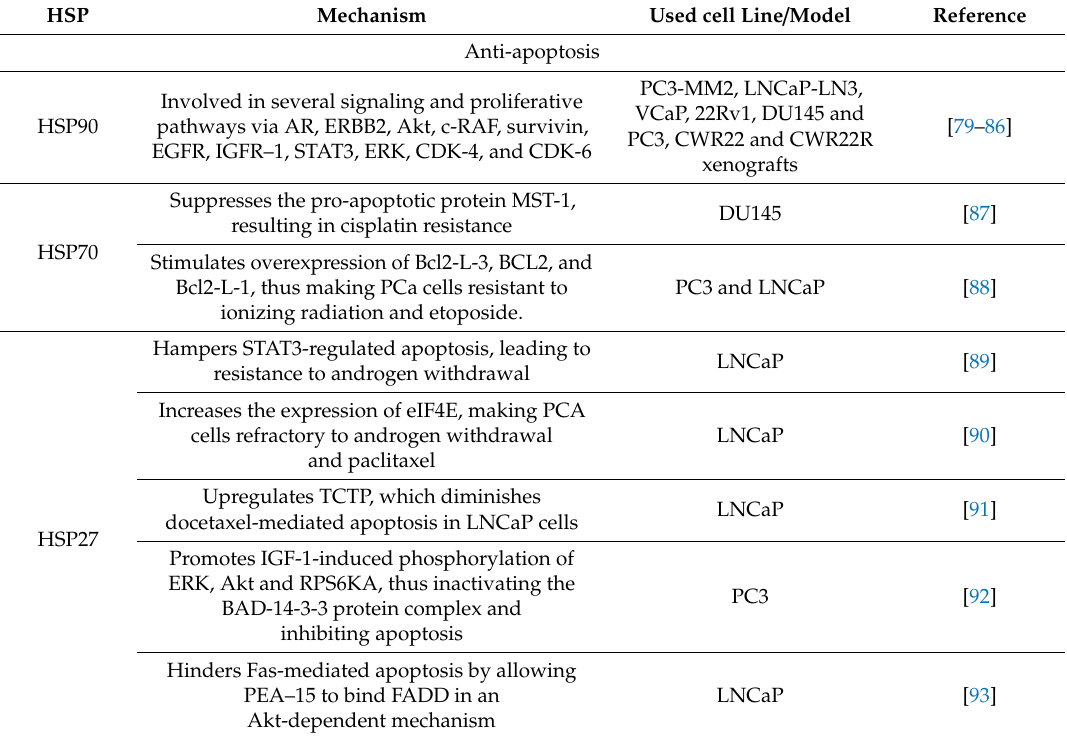
Table 2. Biological functions of HSPs in human prostate